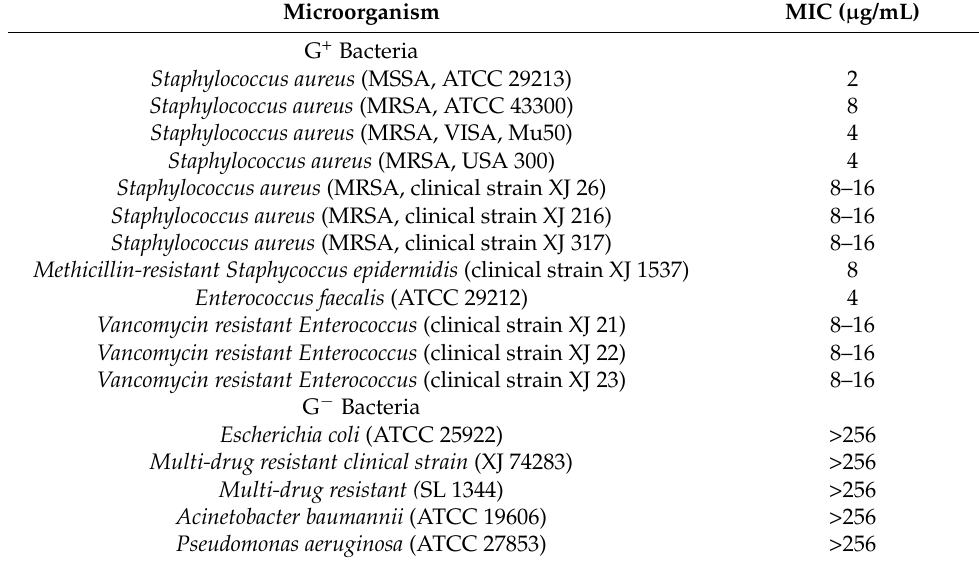
Table 2. Antimicrobial spectrum of